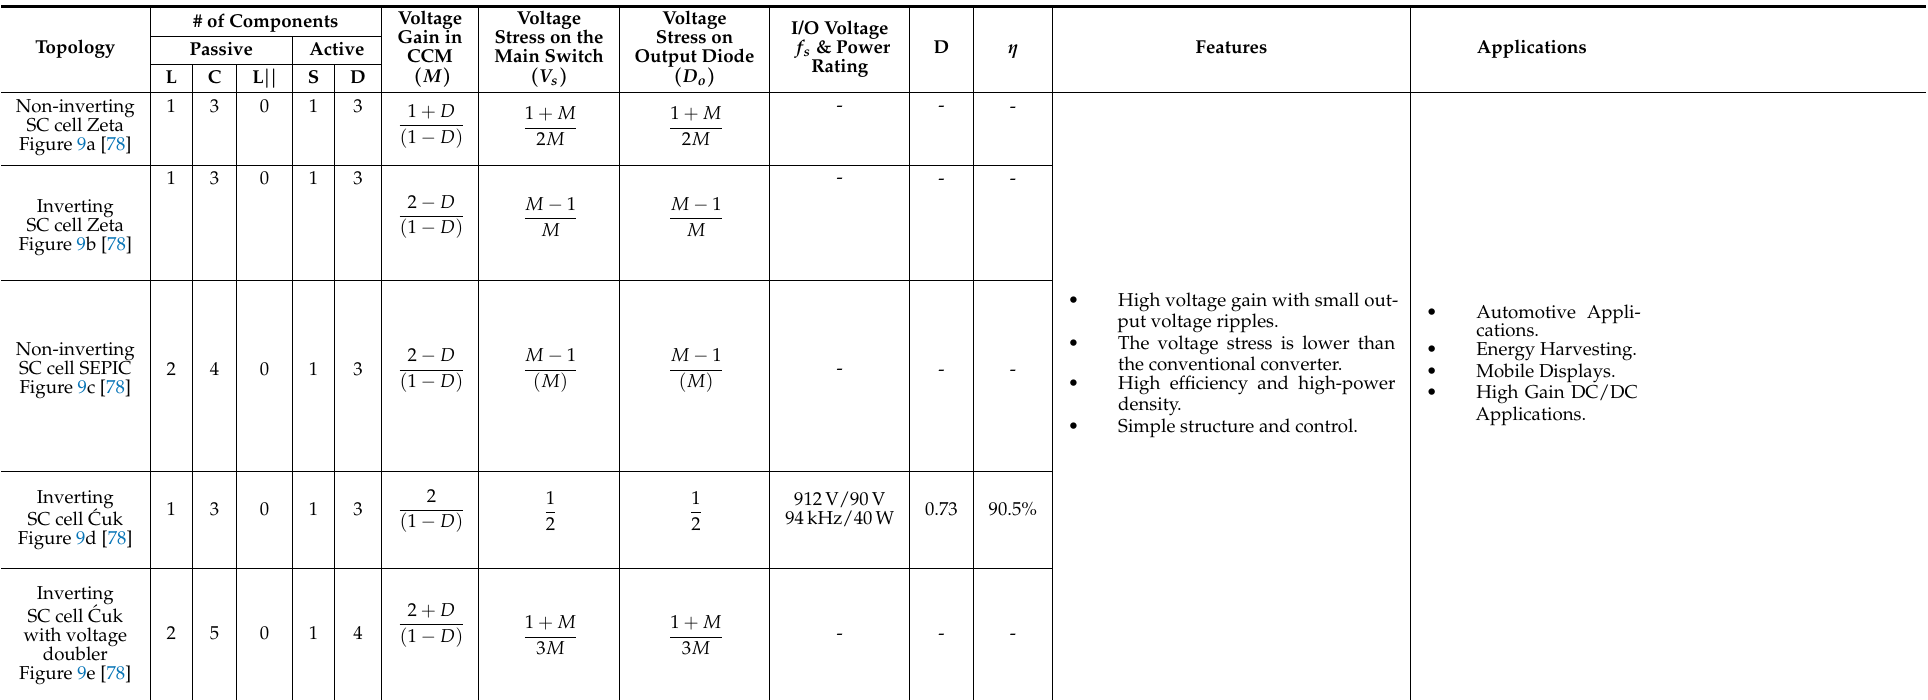
Table 5. Comparison of Switched Capacitor (SC)